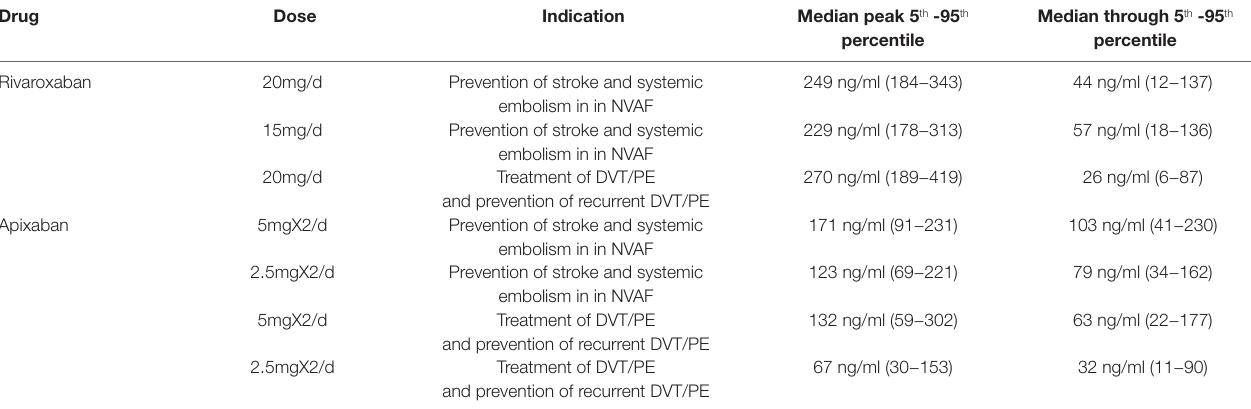
TABLE 2 | Steady state peak and trough levels of apixaban and rivaroxaban (Samama et al., 2013; Bristol-Myers Squibb, 2018). Drug Dose Indication Median peak 5 th -95 th